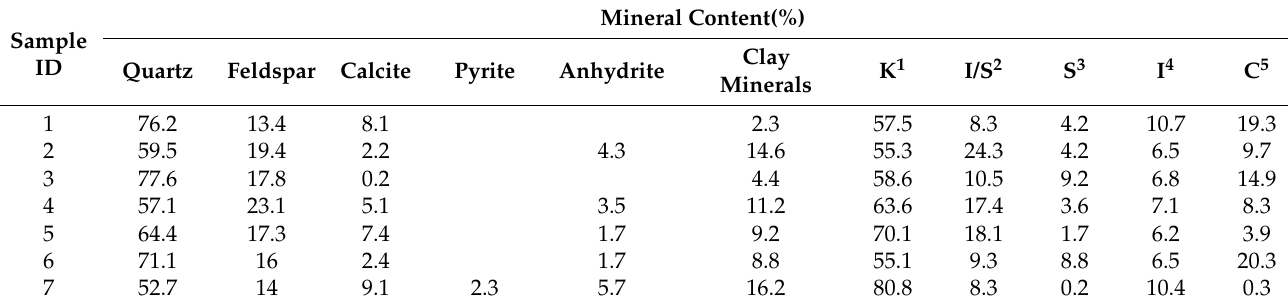
Table 3. Mineral content distribution in the sample.